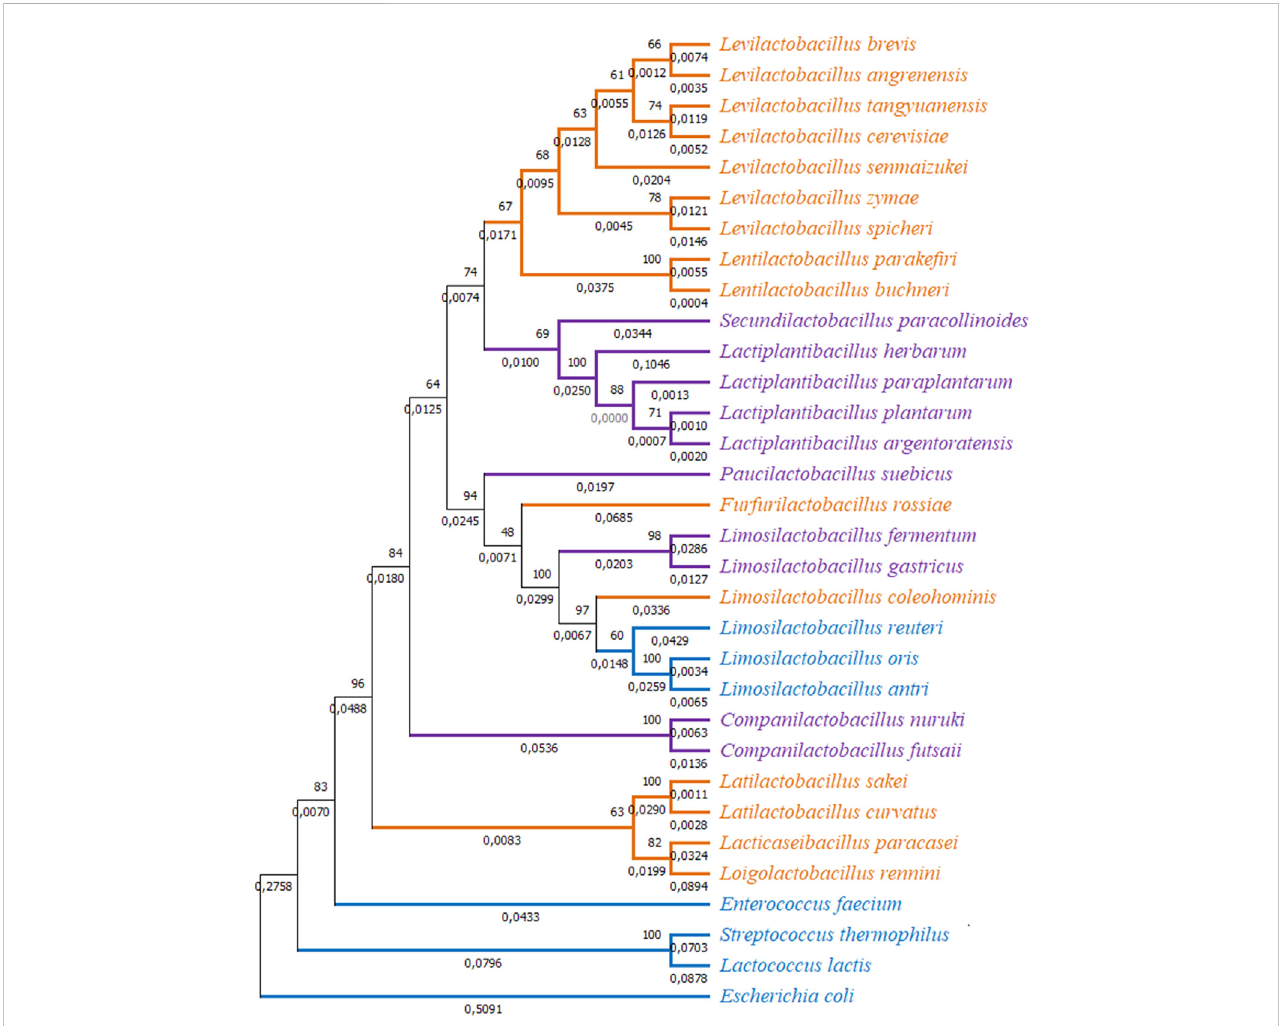
FIGURE 4 Phylogenetic tree based on 16S rRNA sequences from 32 bacterial species. The tree was constructed with MEGA-X using the Maximum Likelihood methodandtheKimura2-parametermodel.Onethousandreplicateswereusedtogeneratethebootstrapconsensustree.AdiscreteGamma(G)distribution was used for evolutionary rate variations across sites. Numbers on the nodes show the bootstrap support, numbers on the branches show substitutions per site. Orange color represents species where GAD pathway genes are organized in an operon structure. Purple color represents species without an operon structure, and blue color represents species with a small operon structure consisting of only a transporter and a GAD